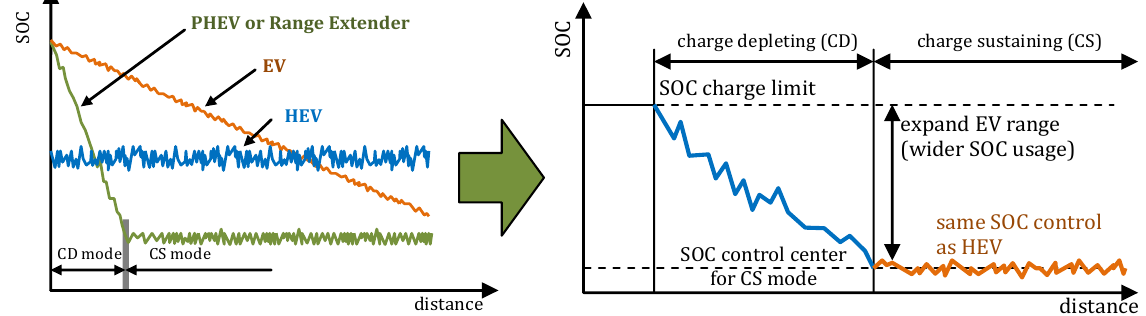
Fig. 1. Range Extender powertrain batteries discharge against purely electric (EV) and hybrid (HEV) drive modes [10,